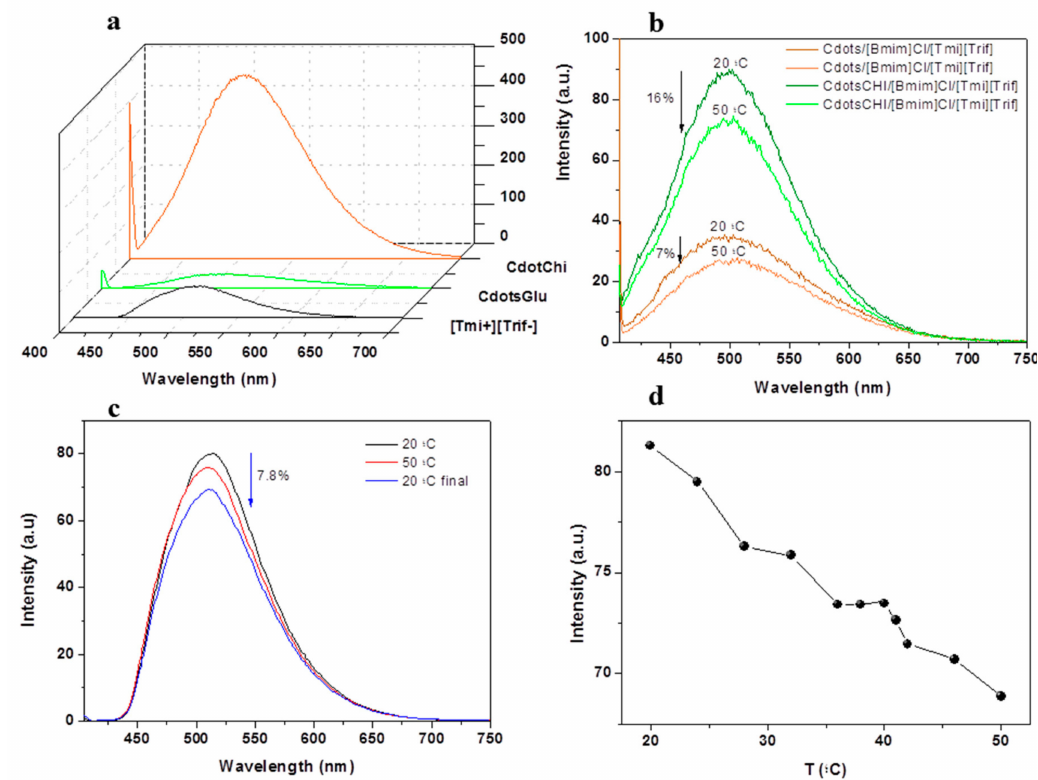
Figure 2. ( a ) Fluorescence emission profile of the two nanofluids and [Tmi][Trif] (excitation wavelength = 400 nm), ( b ) Fluorescence intensity profile for the two nanofluids aqueous solution acquired at 20 ◦ C, and at the end of the first heating cycle (50 ◦ C). ( c ) Fluorescence intensity at the maximum emission wavelength of [Tmi][Trif] (515 nm) as a function of the temperature in the first heating / cooling cycle. ( d ) Fluorescence emission profile of [Tmi][Trif] (excitation wavelength = 400 nm), at 20 ◦ C, at the maximum temperature of the first heating cycle (50 ◦ C), and at 20 ◦ C upon the first heating / cooling